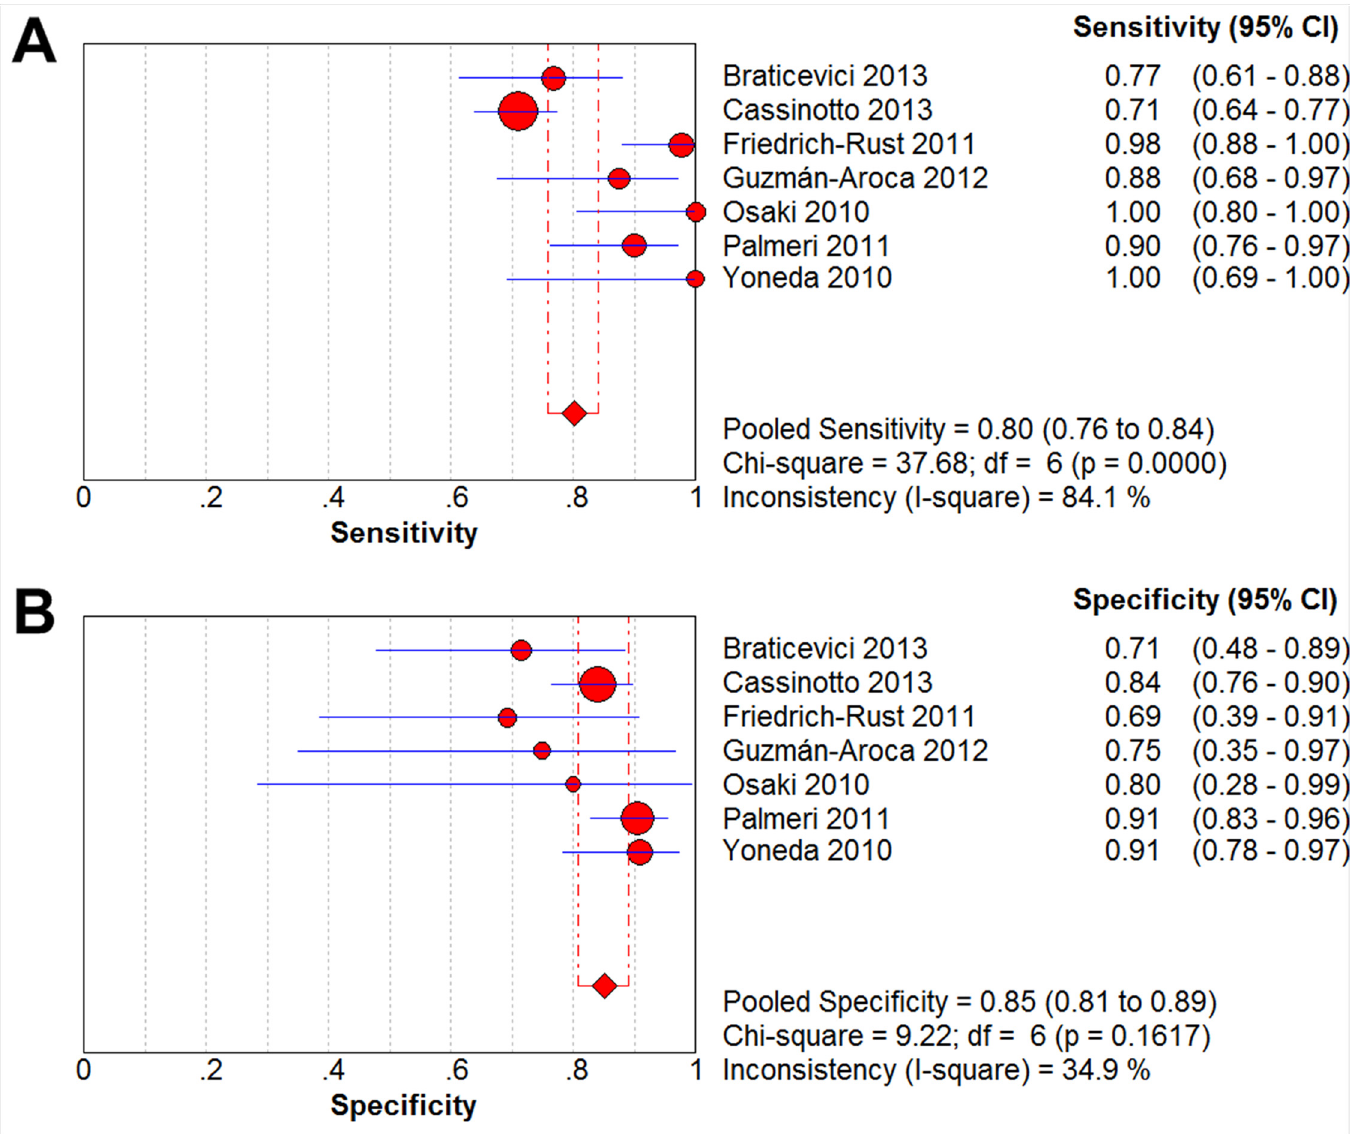
Fig 2. Forest Plots of Sensitivity & Specificity. The red circles and the horizontal blue lines represent the point estimates and 95% confidence intervals (CIs) of the included studies, respectively. The weight of each study is depicted by the size of its respective circle. The center of the red diamond represents the pooled estimate, and the red dotted lines represent the 95% CI of the pooled